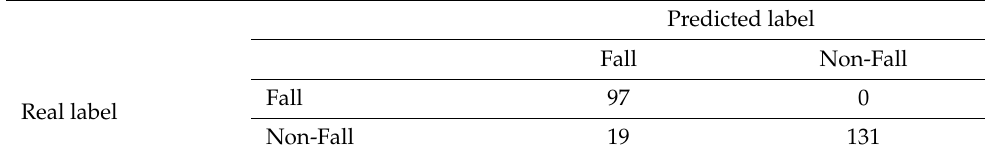
Figure 4. Charfi dataset: Skeleton detected by applying V2V-PoseNet to some frames. Table 1. Charfi dataset: The confusion matrix obtained by applying our